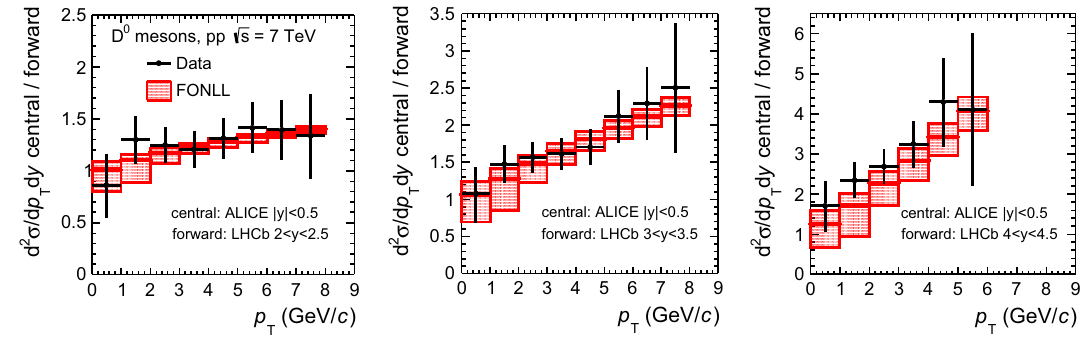
Fig. 9 RatiosofD 0 -mesonproductioncrosssectionperunitofrapidity at mid-rapidity ( | y | < 0 . 5) to that measured by the LHCb Collaboration [19] in three rapidity ranges, 2 < y < 2 . 5 ( left panel ), 3 < y < 3 . 5 ( middle panel ), 4 < y < 4 . 5 ( right panel ), as a function of p T . The